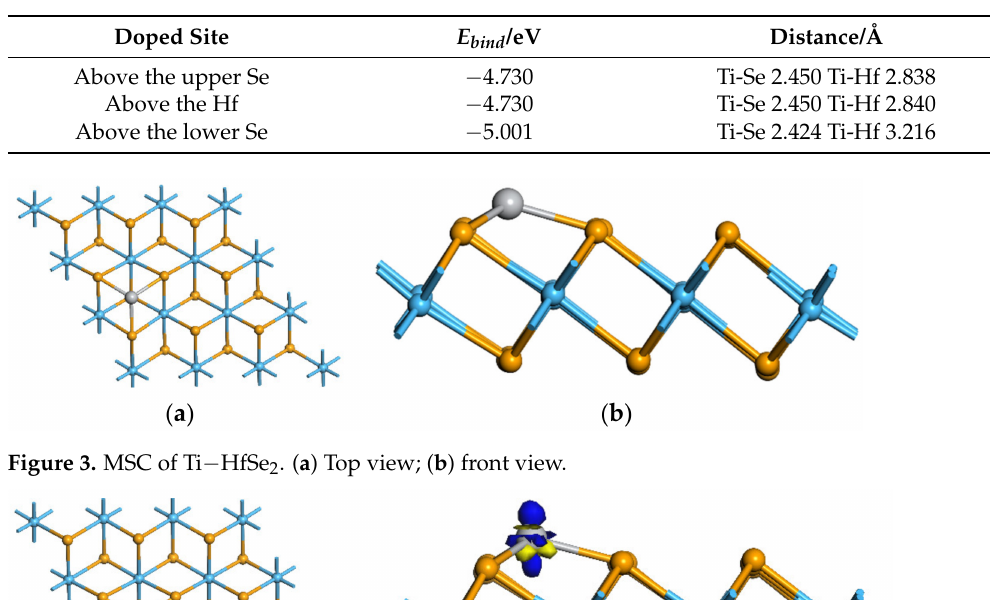
Table 1. Binding energy and distance for different doping positions.